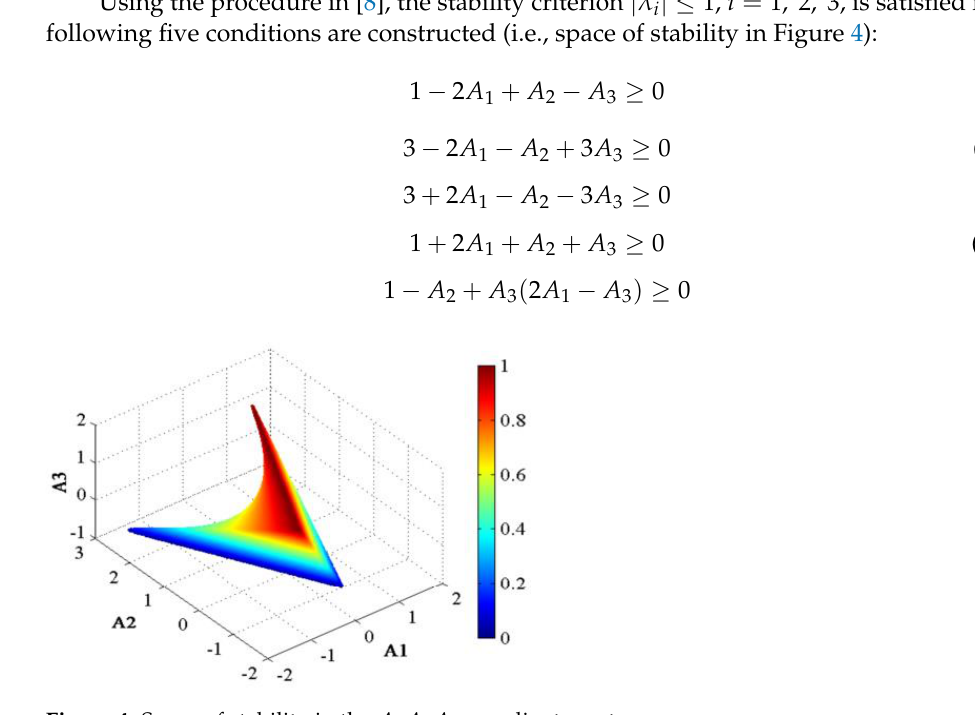
Figure 4. Space of stability in the 𝐴 1 𝐴 2 𝐴 3 coordinate system.